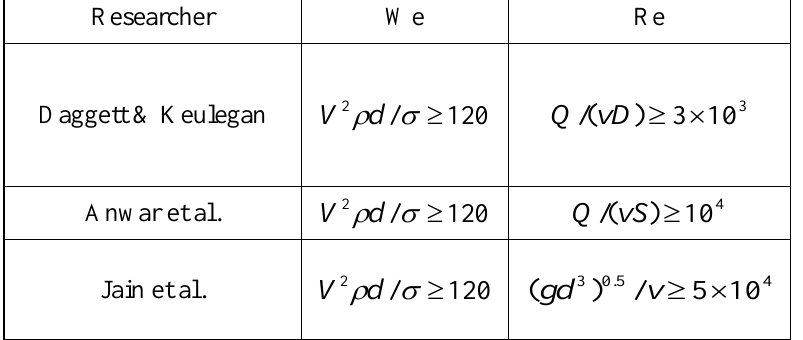
Table1 The ranges of the Weber and Reynolds numbers for neglecting the effect of the surface tension and